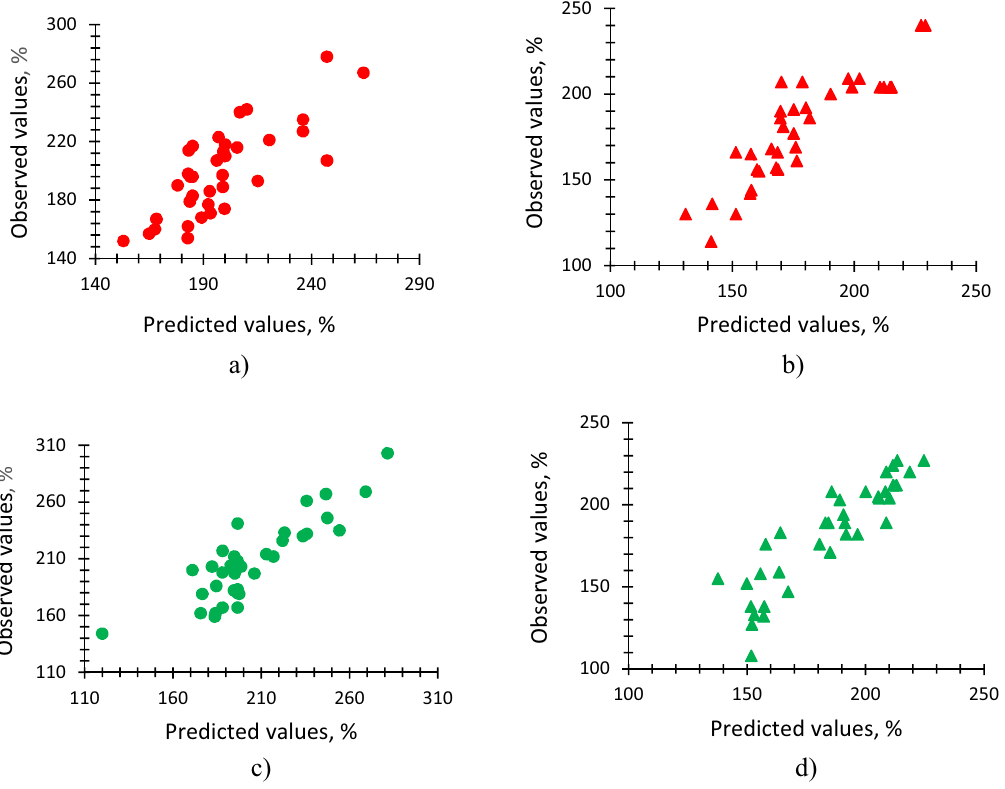
Figure 2: Observed versus predicted diagram for anticonvulsant activities of terpene derivatives: ( a ) DCTC ( 3 h ) ; ( b ) DCTC ( 24 h ) ; ( c ) DTE ( 3 h ) ; and ( d ) DTE ( 24 h )